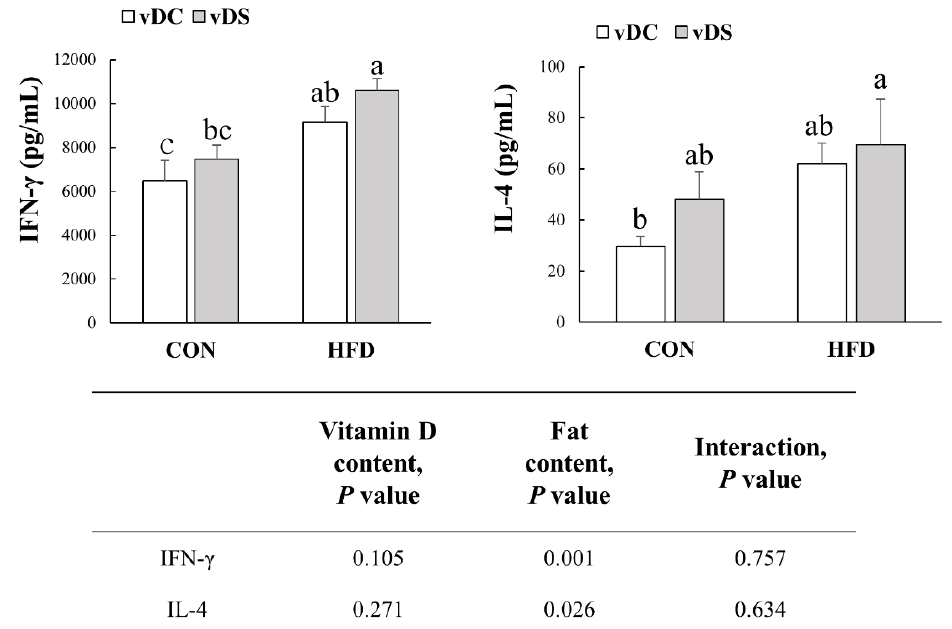
Figure 3. Production of IFN-γ and IL-4 by T cells. Splenic T cells were stimulated with anti-CD3/anti-CD28 mAbs for 48 h and supernatants were harvested to determine the amount of IFN-γ and IL-4 by ELISA. Data are presented as means ± SEMs, n = 7 per group. Two-way ANOVA was used to determine the significant effects of fat and vitamin D contents, and an interaction. a,b Different superscripts indicate significant difference ( p < 0.05) among individual groups, by Fisher's least significant difference multiple comparison test. CON-vDC, 10% kcal fat diet + vitamin D control; CON-vDS, 10% kcal fat diet + vitamin D supplemented; HFD-vDC, 45% kcal fat diet + vitamin D control; HFD-vDS, 45% kcal fat diet + vitamin D supplemented.